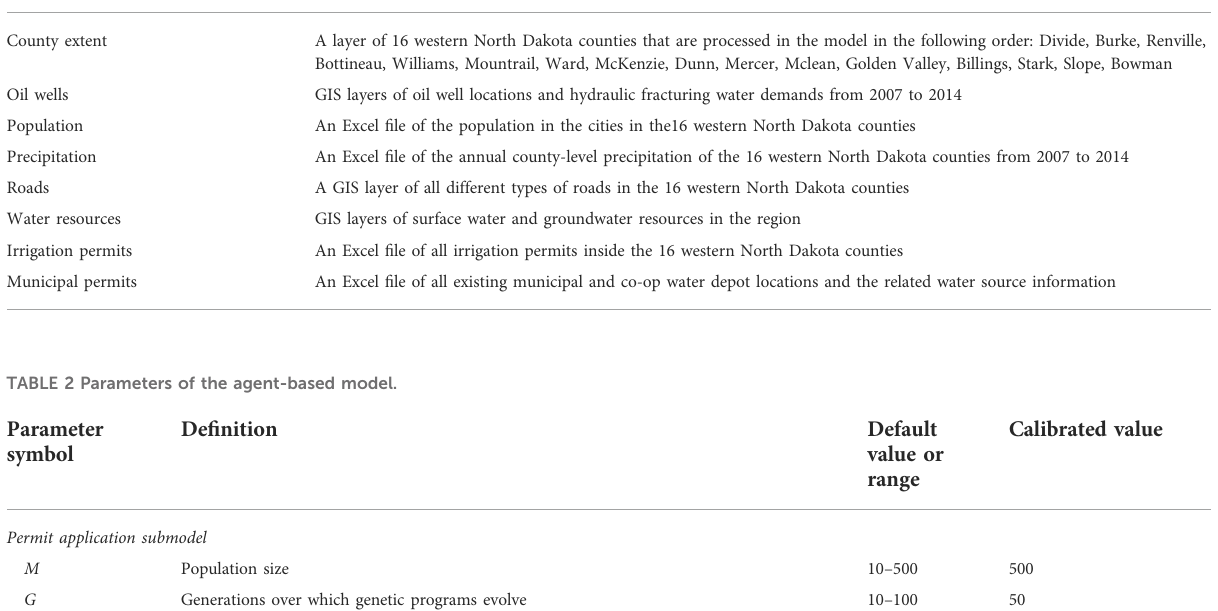
TABLE 1 Input data for the agent-based model.